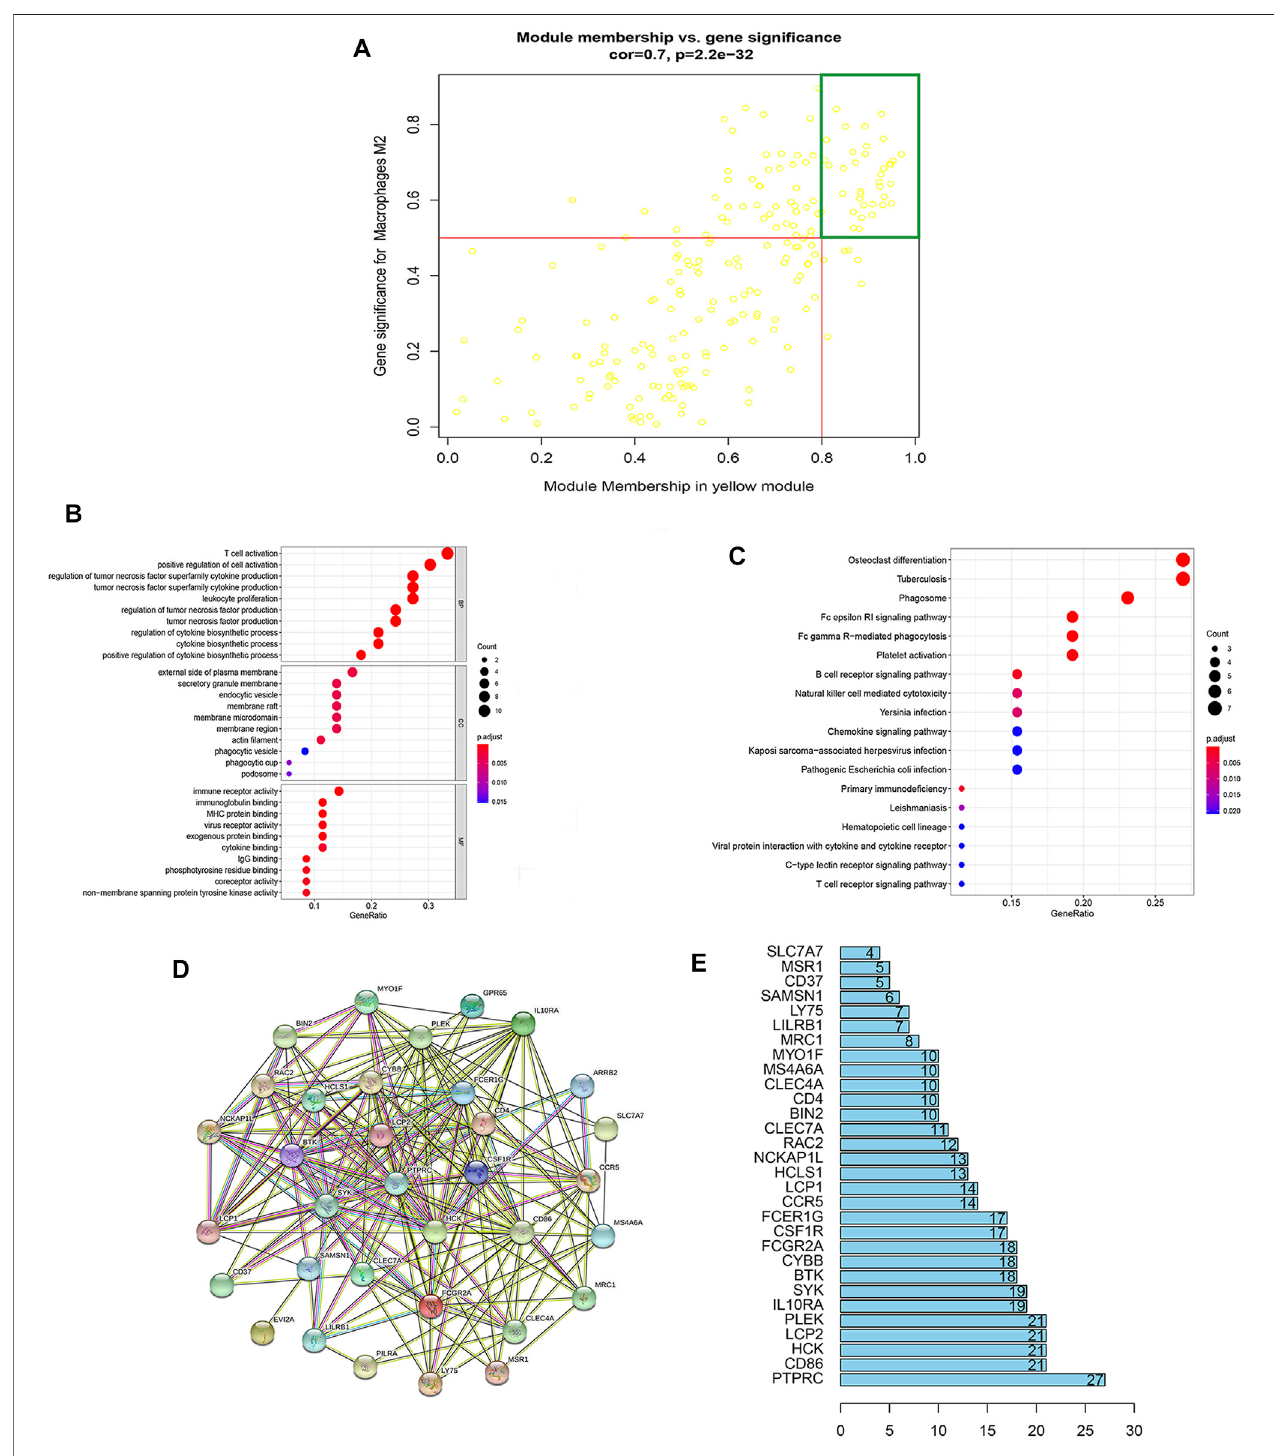
FIGURE 3 | Enrichment analysis and PPI construction of hub genes in key modules. (A) Module membership in yellow modules and gene signi fi cance for M ϕ 2. Each yellow dot indicates a gene. Genes with module membership values > 0.8 and gene signi fi cances > 0.5 inside the green box are candidate hub genes. (B) GO analysisofhubgenes:biologicalprocess(BP),cellularcomposition(CC),andmolecularfunction(MF)ofhubgenes. (C) KEGGanalysisofhubgenesidenti fi edthetop18 pathways, dot sizes re fl ect the number of genes associated with relative pathways, and dot colors indicate the p -values. (D) Protein – protein interaction (PPI) networkofhubgeneswasconstructedusingtheSTRINGdatabase. (E) Histogrambasedonthenumberofprotein – proteinactingnodesshowninthenetwork(onlythe top 30 are shown).